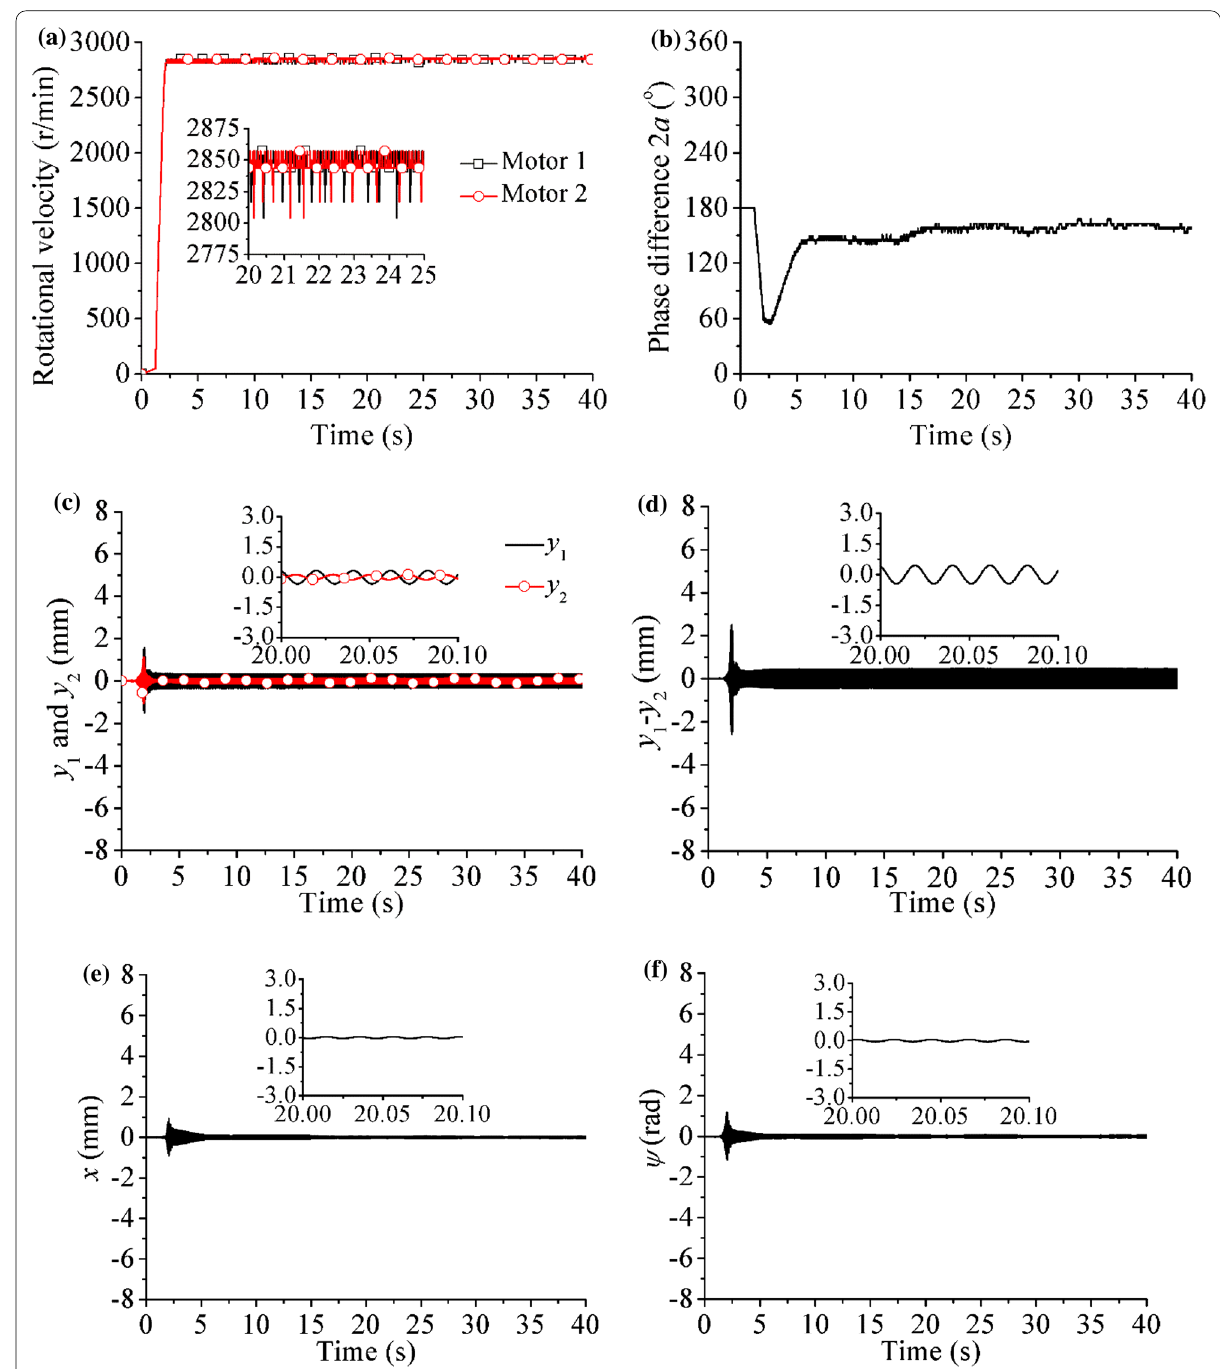
Figure 8 Experimental results in the near super-resonant state for ω 0 : a Rotational velocities of the two motors, b Phase difference between the two vibrators, c Displacement: y 1 and y 2 in the steady state, d Displacement: y 1 Displacement: ψ in the steady